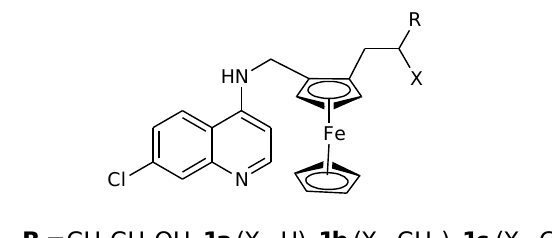
Figure 2. Chemical structure of compound hydroxyferroquine derivatives ( 1a – c ).